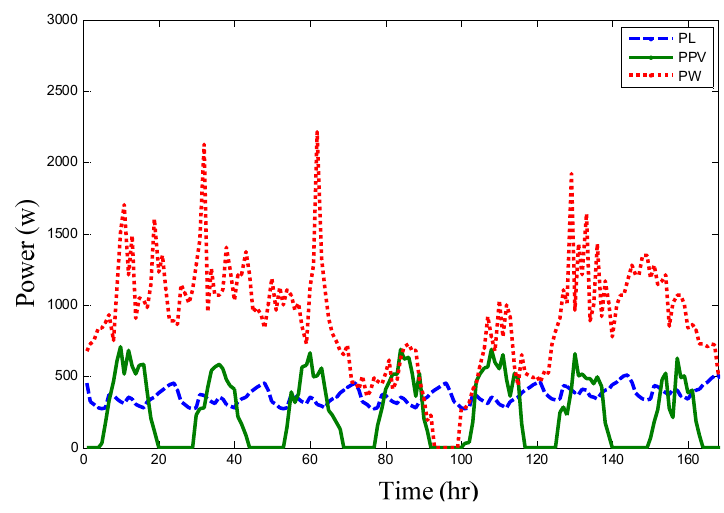
Figure 8. The power curves of the power system in the first week of December.